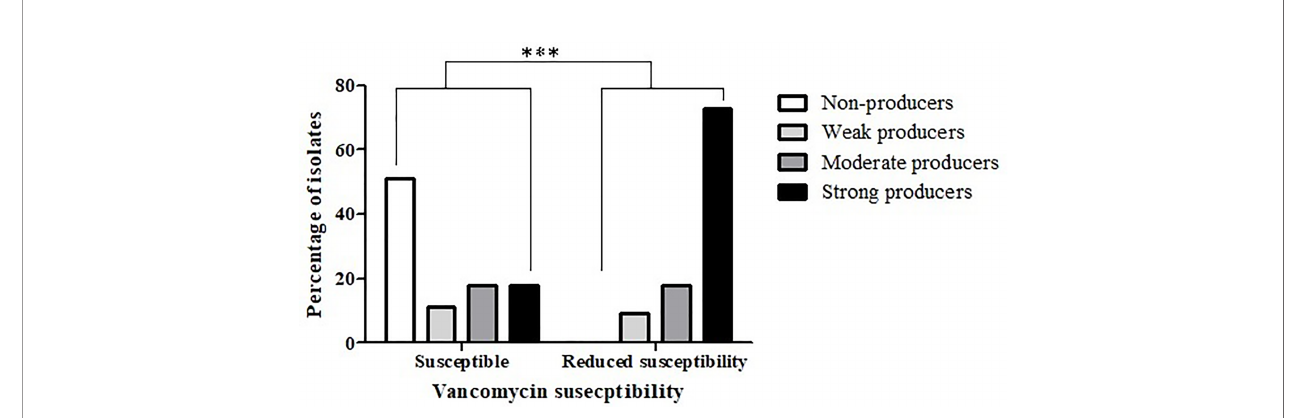
FIGURE 3 | Bio fi lm production capacity among isolates that are vancomycin-susceptible and isolates with reduced vancomycin- susceptibility. The bio fi lm- production capacity of C. dif fi cile isolates was compared between isolates that are vancomycin-susceptible (n = 112) and isolates with reduced vancomycin susceptibility (n = 11) isolates (*** p < 0.0001). The p value represents the comparison of the bio fi lm production capacity between susceptible isolates and isolates with reduced susceptibility (Chi square